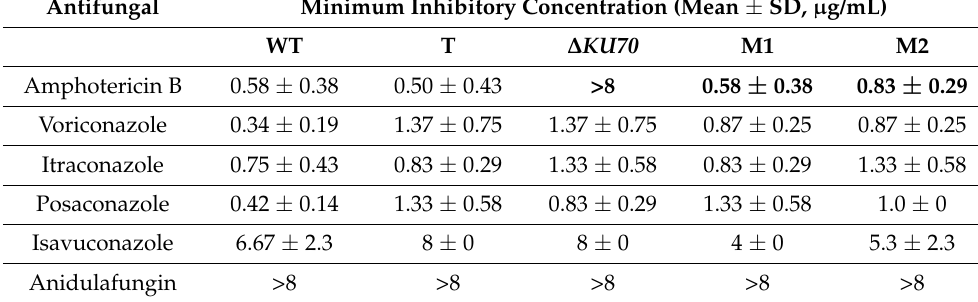
Table 1. Minimum inhibitory concentration (MIC) determined by the broth microdilution method. MICs determined after incubation for 72 h at 37 ◦ C as the lowest concentration of antifungal to result in a growth reduction of 90% (amphotericin B) or 50% (triazoles) relative to the growth control in antifungal-free RPMI. Growth was assessed by measuring the optical density at 405 nm. Significant differences in the MIC are shown in bold. T: transformant derived from the WT strain; M1 and M2: transformants derived from the ∆ KU70